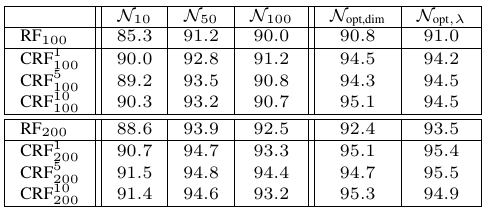
Table 1. Overall accuracy OA [%] achieved in all experiments.